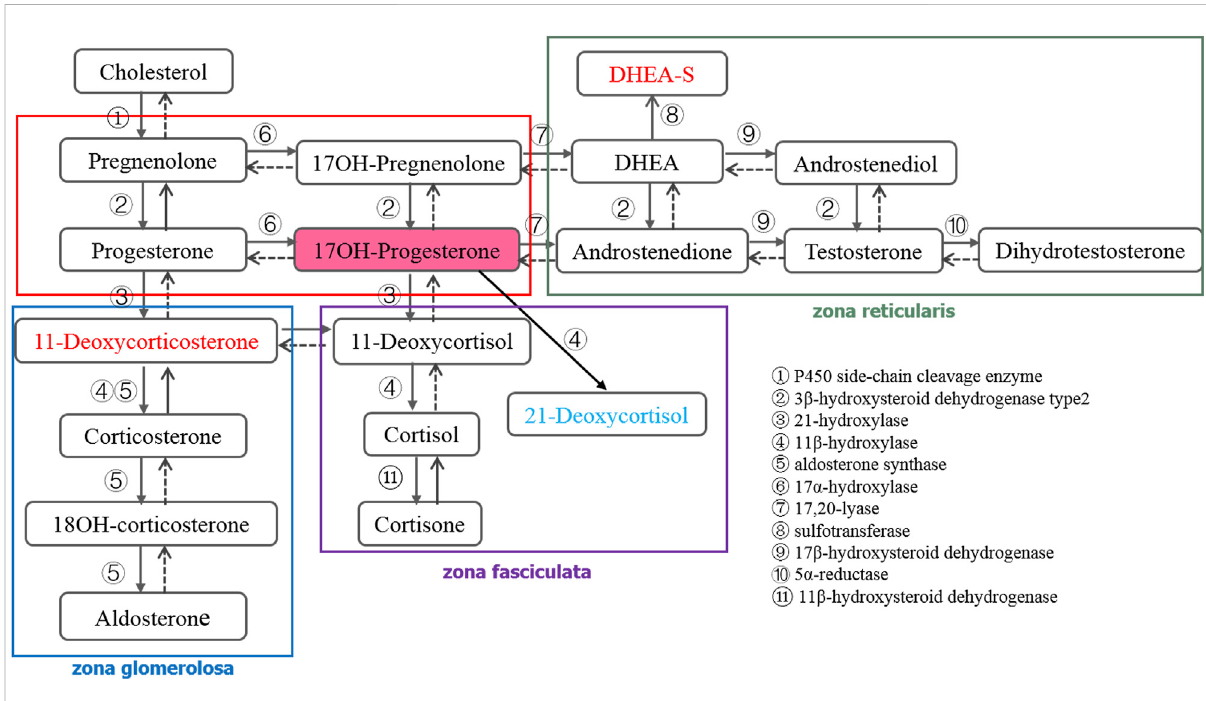
FIGURE 1 Synthetic and metabolic pathways of adrenal corticosteroid